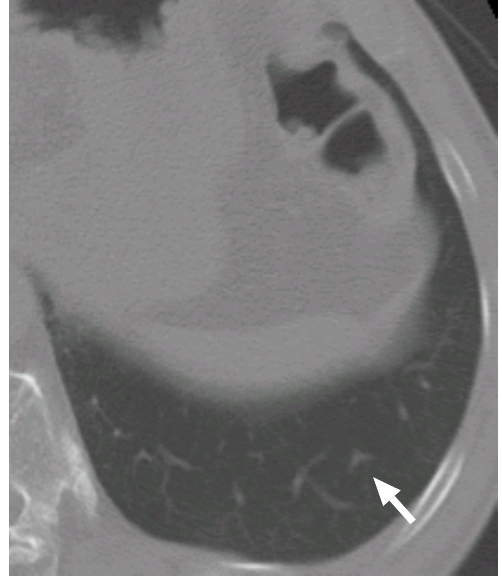
Figure 12. A bifurcation in a blood vessel